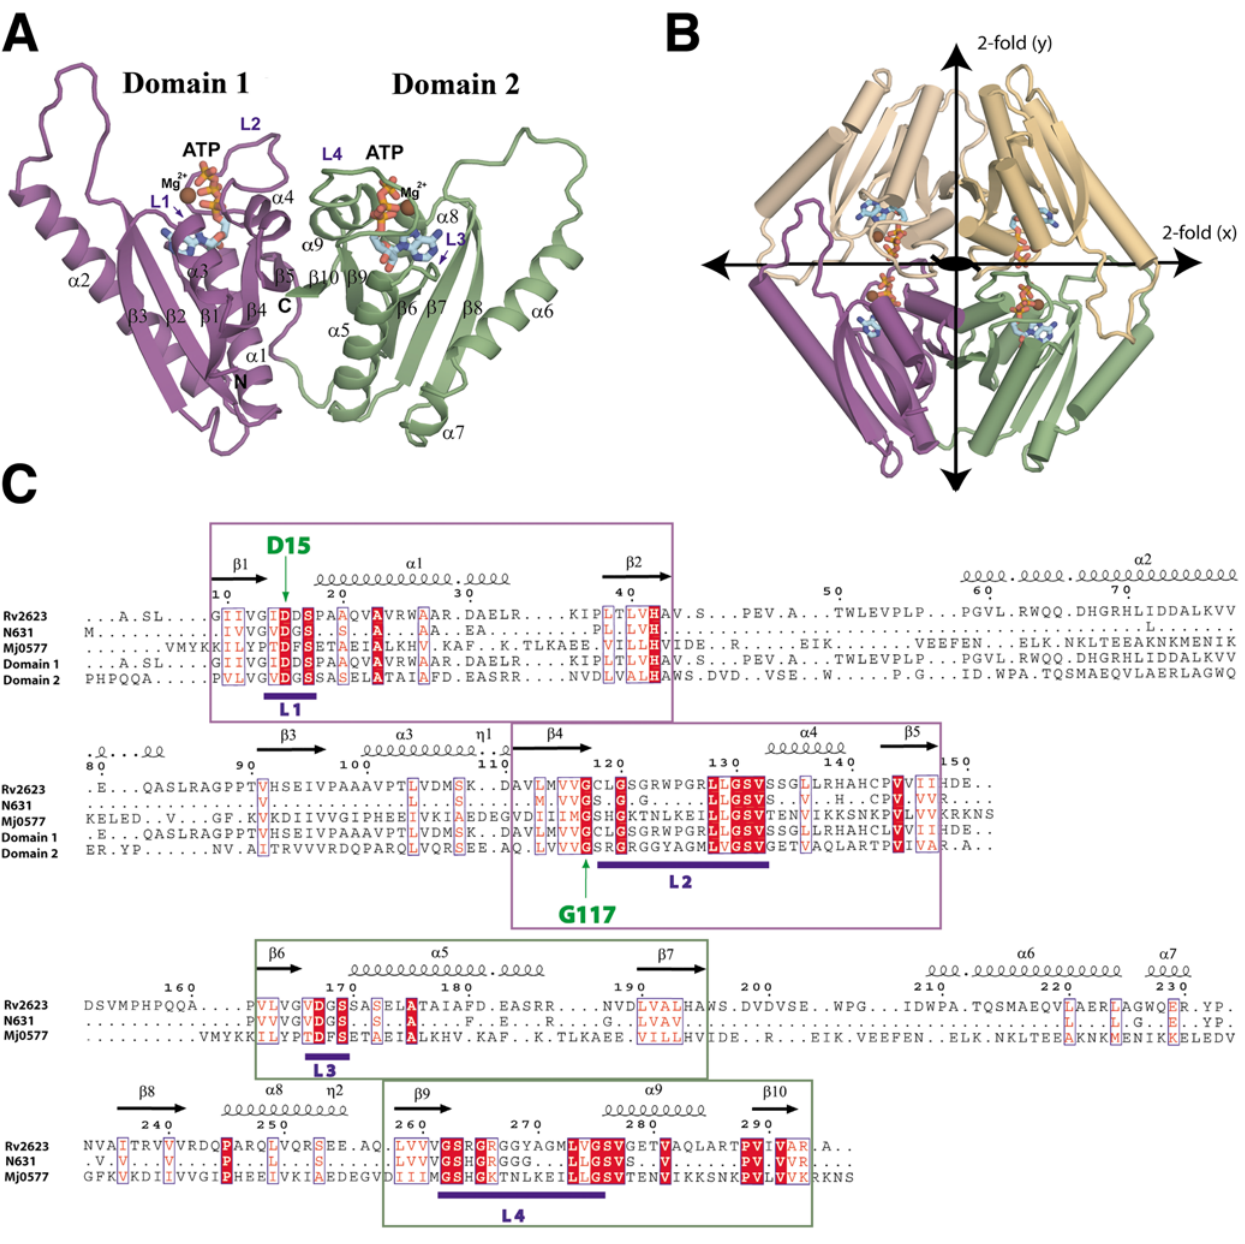
Figure 6. Structure and phylogeny of Rv2623 from M.tuberculosis . (A,B) A ribbon representation of the Rv2623 monomer (A) and dimer (B) with bound ATP (sticks) and Mg 2 + (chocolate spheres). The three, mutually perpendicular pseudo-two-fold axes of the dimer are represented by lines with double arrows (along x, y) and a central ellipse (along z). The atoms of the bound ATP are colored cyan (carbon), red (oxygen), blue (nitrogen), and orange (phosphorus) in (A) and (B). (C) A structure-based sequence alignment of Rv2623, the N631 subfamily consensus, Methanococcus jannaschii protein 0577 (MJ0577), and domains 1 and 2 of Rv2623. Invariant residues in the alignment ( . 85% conserved in N631) are shaded in bold red and similarities are boxed in blue but left unshaded. Regions with consensus ATP binding motifs comprising L1/L2 (domain 1) and L3/L4 (domain 2) are colored dark violet and smudge, respectively. The positions of the mutated amino acids (D15, G117) are indicated in green. The structure-based sequence alignment was produced using ESPript and the structural representations were produced using